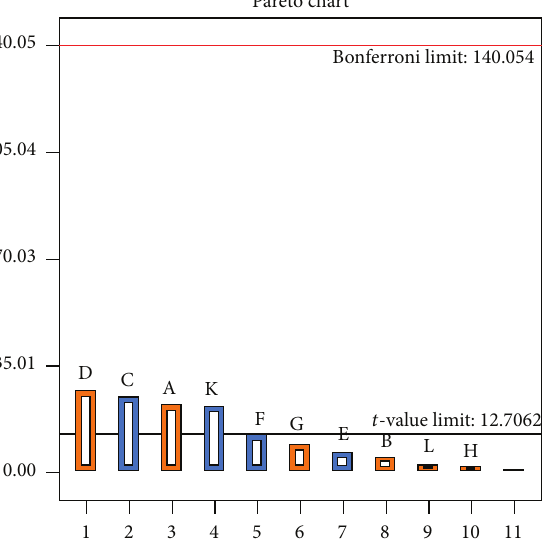
Figure 4: Effect of various levels of pH on rifamycin B production by Nocardia mediterranei MTCC 14 using sunflower oil cake under solid-state fermentation.